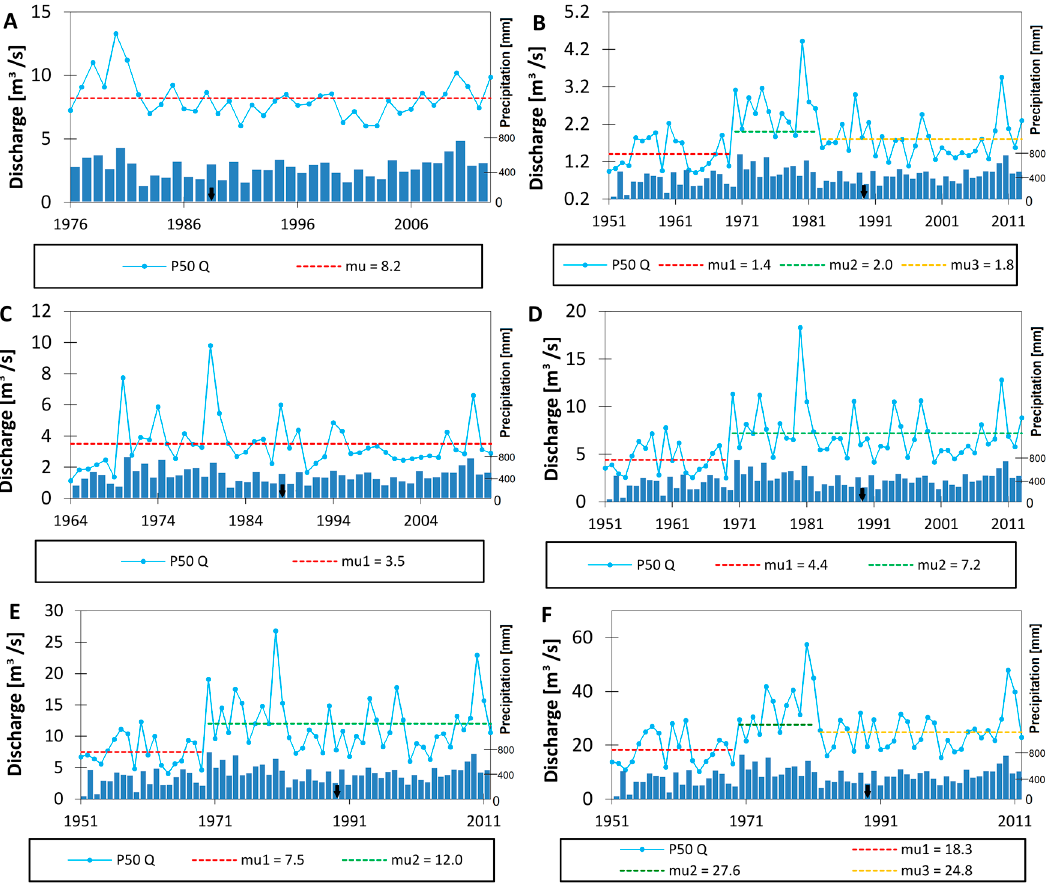
Figure 5. Annual second quartile discharge for selected gauge stations of the Upper Narew Catchment: ( A ) Fasty, ( B ) Narewka, ( C ) Bondary, ( D ) Narew, ( E ) Sura ż , and ( F ) Str ę kowa Góra. “mu” stands for the average value of each time period. The black arrow indicates the year the SR started operation.